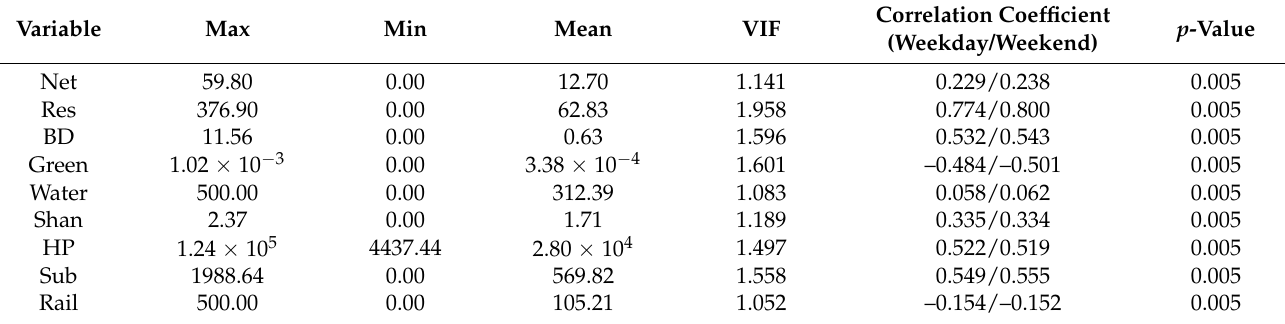
Table 3. Statistical characteristics of the impact indicators.